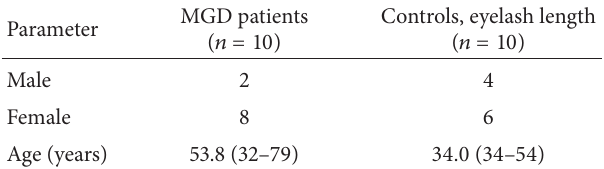
Table 1: Composition of Eye Shampoo Long. Table 2: Demographic characteristics of study participants.